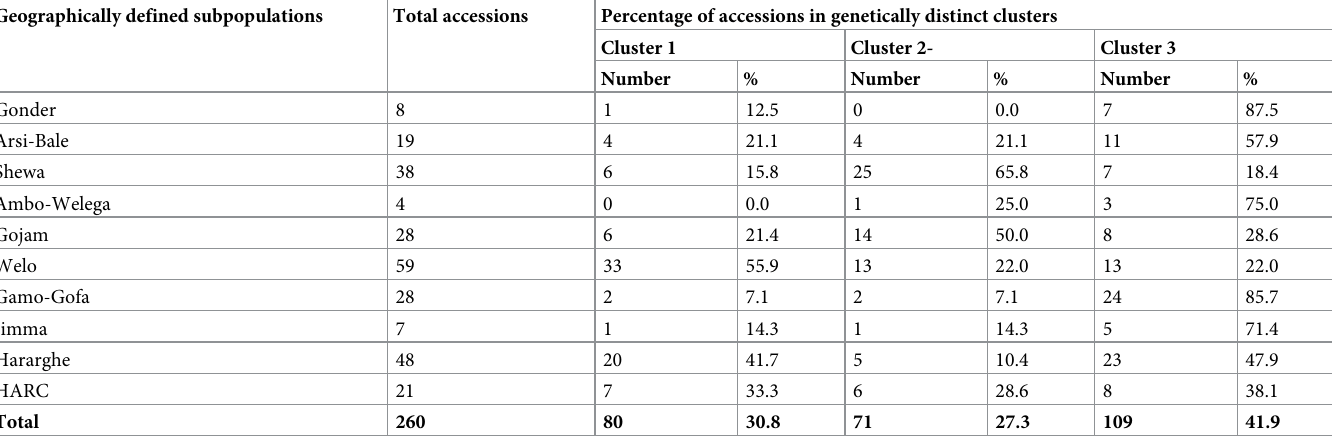
Table 1. Distribution of the Ethiopian barley accessions grouped by their geographical origin and based on the three genetically distinct clusters. Geographically defined subpopulations Total accessions Percentage of accessions in genetically distinct clusters Cluster 1 Cluster 2- Cluster